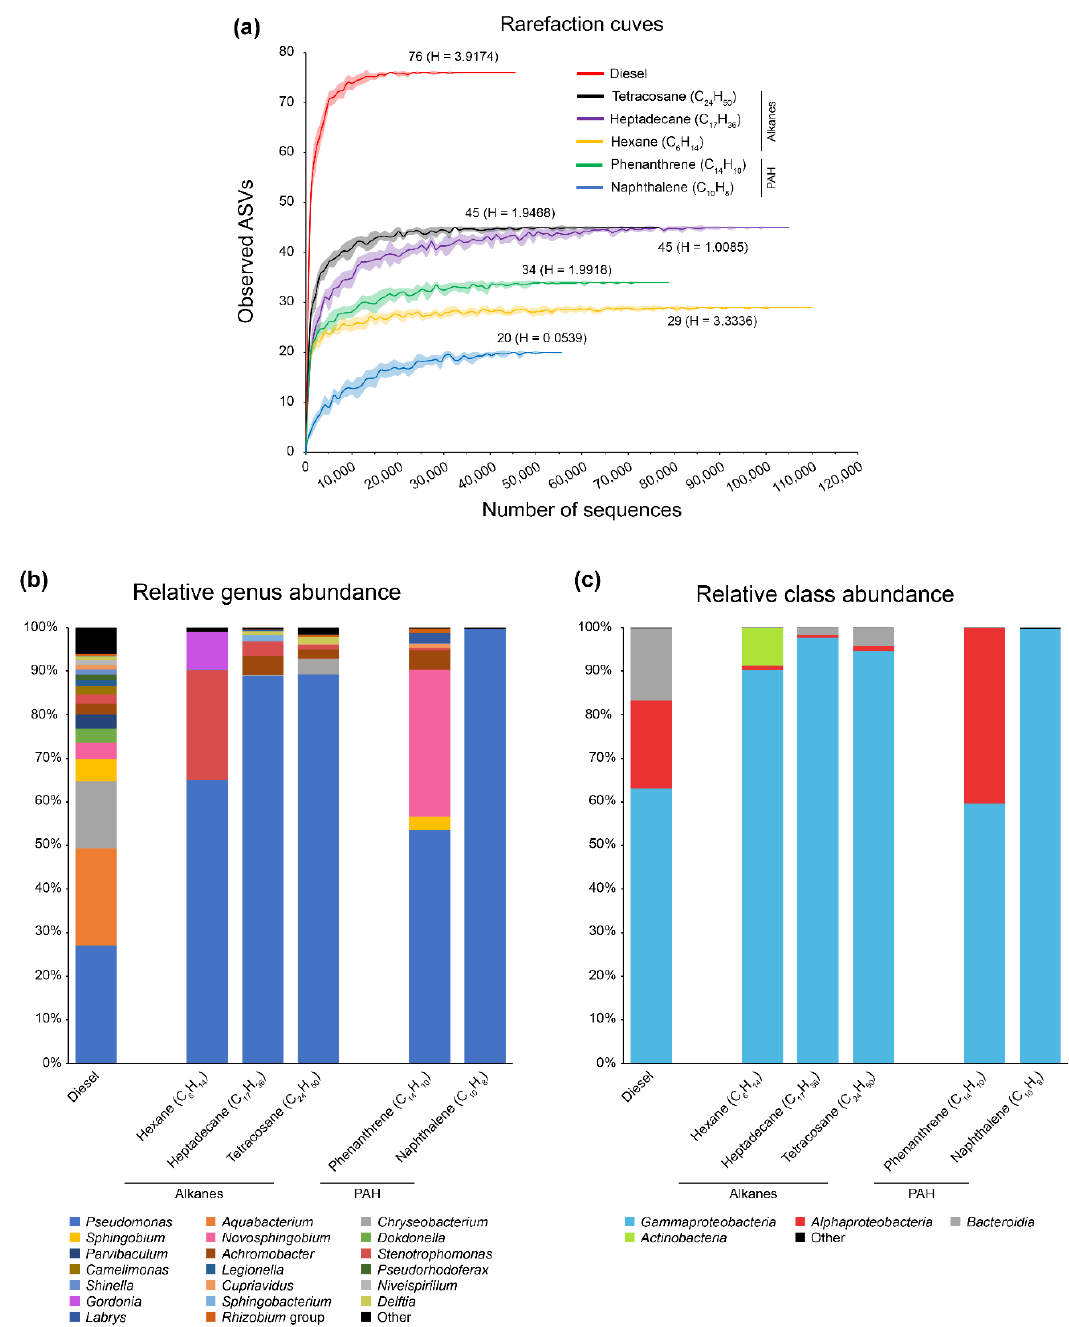
Figure 1. Diversity and taxonomic composition of the diesel-degrading consortium growing on diesel and different alkanes and polycyclic aromatic hydrocarbons (PAHs) as sole carbon and energy source. ( a ) Rarefaction curves of observed amplicon sequence variants (ASVs) over the number of sequences sampled. Lines represent mean values while colored shadows represent standard deviation over 10 iterations. All curves show complete community coverages. Number of ASVs in each microbiome and Shannon diversity index (H) are indicated above/below each curve. ( b ) Relative genus abundance or ( c ) class abundance based on 16S rRNA. Only taxa with a minimum relative abundance of 1% across samples are represented. For detailed abundance distribution, see Supplementary Table S1.